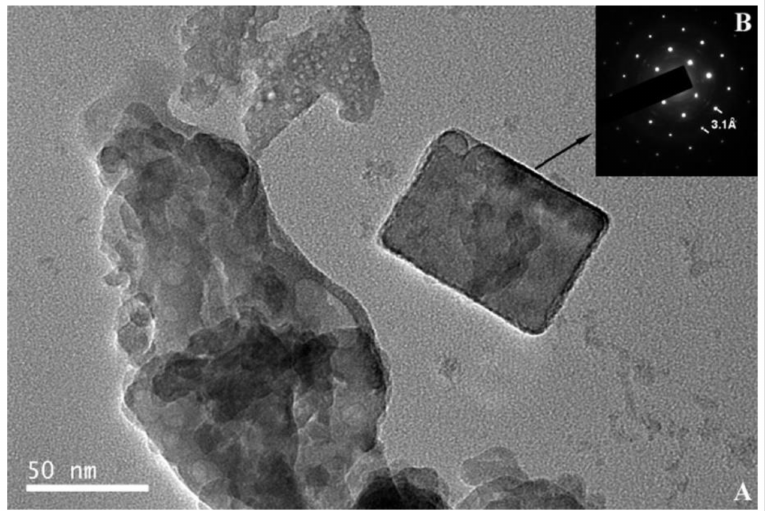
Figure 23. TEM image of a fluorite crystal for an OPC mortar sample aged for 6 h. Selected area electron diffraction pattern showing 3.1 Å d -spacing of (111) reflection [108]. Reproduced with permission from La Iglesia, A. et al., Constr. Build. Mater.; Published by Elsevier,